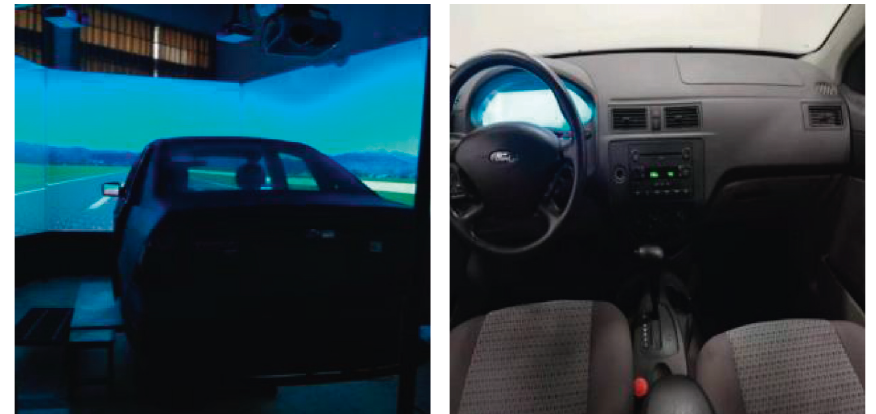
Figure 1: Driving simulator.